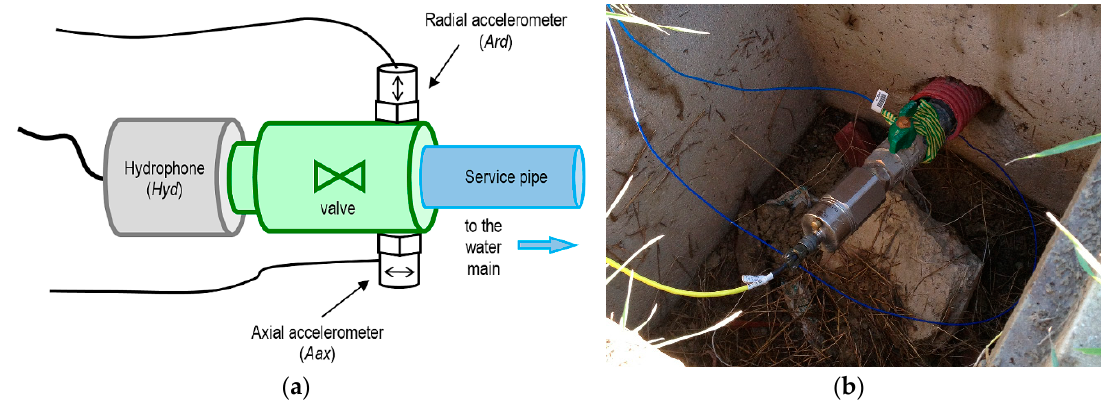
Figure 2. Sensor setup: ( a ) Schematics; ( b ) close-up of the transducers.